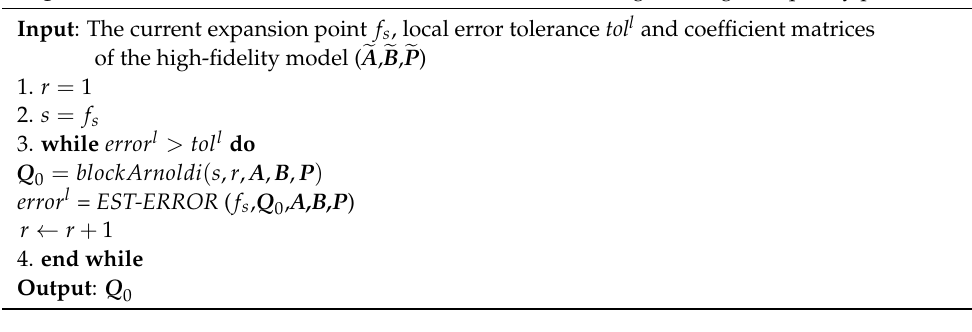
Algorithm 2. S-POINT: Block Arnoldi-based moment matching at a single frequency point